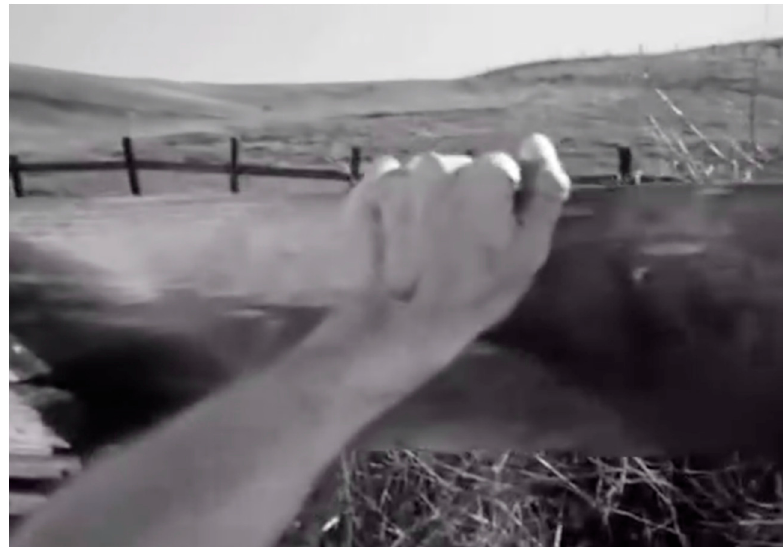
Figure 12. Image from Dark Passage (1947) [37].